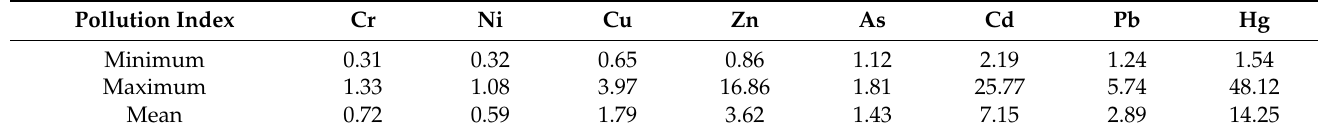
Table 6. Heavy metals’ Pollution Index (PI) in road dust